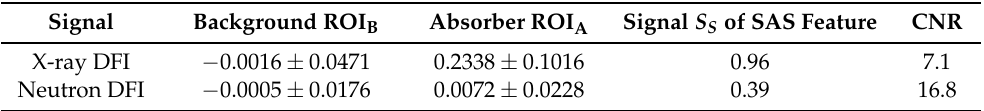
Figure 4. ( a ) Rendering of the X-ray micro-CT reconstruction with an incision to illustrate the hollow inner structure of the quartz geode. Slices from the filtered back-projection (FBP) ( b – e ) in the yz-plane showing the neutron attenuation ( b ), neutron dark-field ( c ), X-ray attenuation ( d ) and X-ray dark-field ( e ) channels. Slices ( f – i ) in the xy-plane depicting the neutron attenuation ( f ), X-ray attenuation ( g ), neutron dark-field ( h ) and X-ray dark-field ( i ) channels. The color bars in ( f – i ) apply to the respective slices in ( b – e ) as well, and the upper boundaries correspond to maximal values of the FBP found in the respective slices. Table 1. Comparison of X-ray and neutron DFI signals and CNRs of a scattering feature shown in Figure